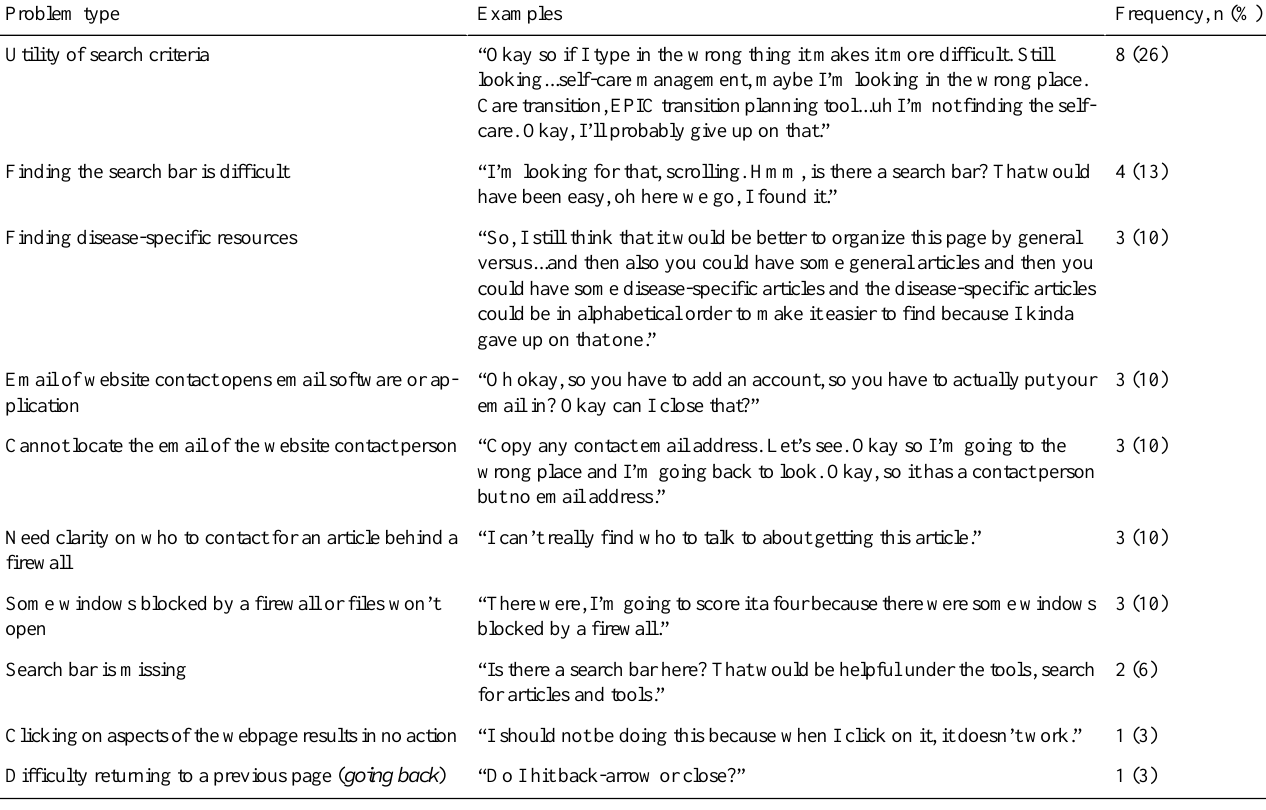
Table 1. Frequency of detected T3 problems by type